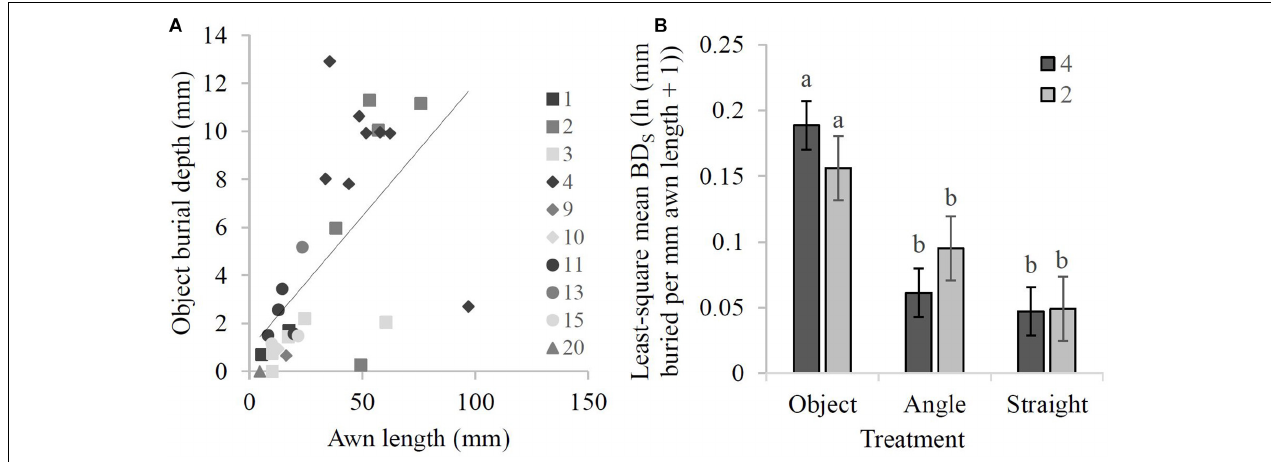
FIGURE 5 | Depth buried by awn types in the burial experiment. (A) Linear regression of awn length against burial depth (BD A ) (in mm; after 21 days) for all 30 species in the Object treatment ( y = 0.1107 x + 0.9274, r = 0.61). Legend shows awn type. (B) Least-square mean values for burial depth (after 21 days) across